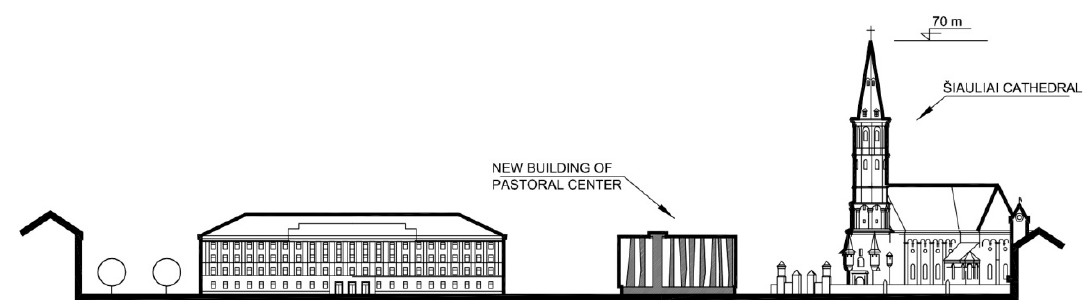
fig. 14. a new building of the Pastoral Center of the Šiauliai major square broke the former harmony due to its pretentious architecture